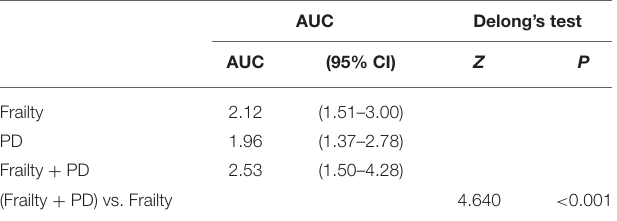
TABLE 4 | Receiver operating characteristic (ROC) analysis of the predictive accuracy of physiological dysregulation (PD) and physical frailty for mortality.